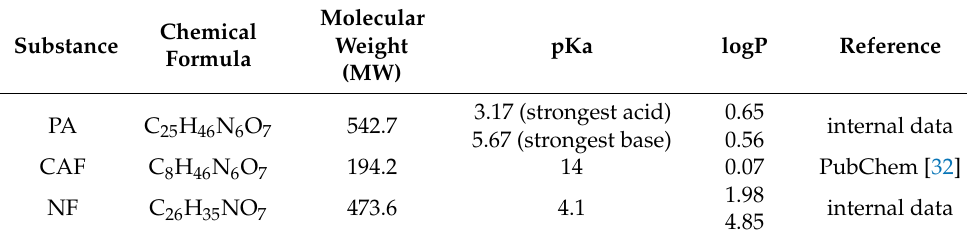
Table 2. Physicochemical properties of